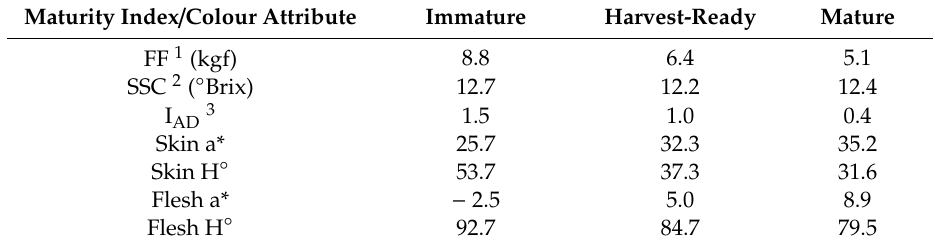
Figure 3. Normalised fluorescence emission spectra for three individual ‘August Flame’ fruit at different maturity classes. Immature: Index of absorbance difference (I AD ) > 1.3; harvest-ready: 1.3 ≤ I AD ≤ 0.7 and mature = I AD < 0.7 (see Table 1). Table 4. FF, SSC, I AD , skin and flesh a* and H ◦ in three individual ‘August Flame’ fruit shown in Table 4. FF, SSC, I AD , skin and flesh a* and H° in three individual ‘August Flame’ fruit shown in Figure Figure 3.